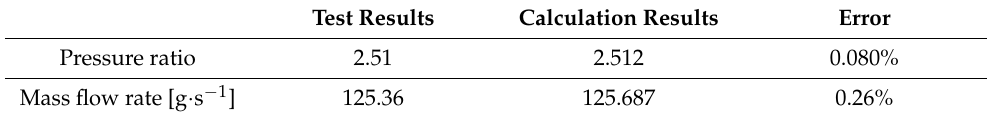
Table 5. Error of the CFD results.